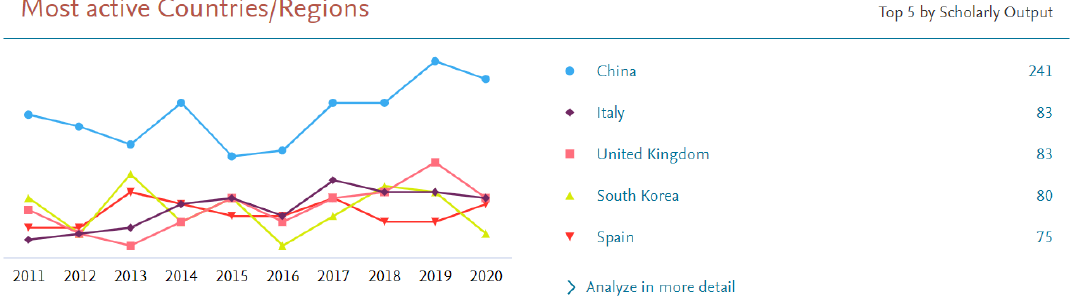
Figure 5. Most active Countries/Regions for the topic «T.18162 Facades; Blinds; Natural Ventilation». The most active Authors for the topic «T.18162 Facades; Blinds; Natural Ventilation» are shown at Figure 6.